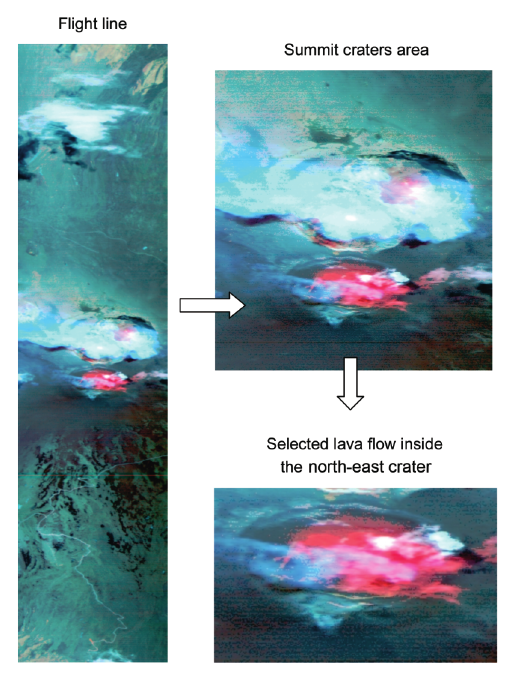
Fig. 1. DAIS flight line imaged on 16th July